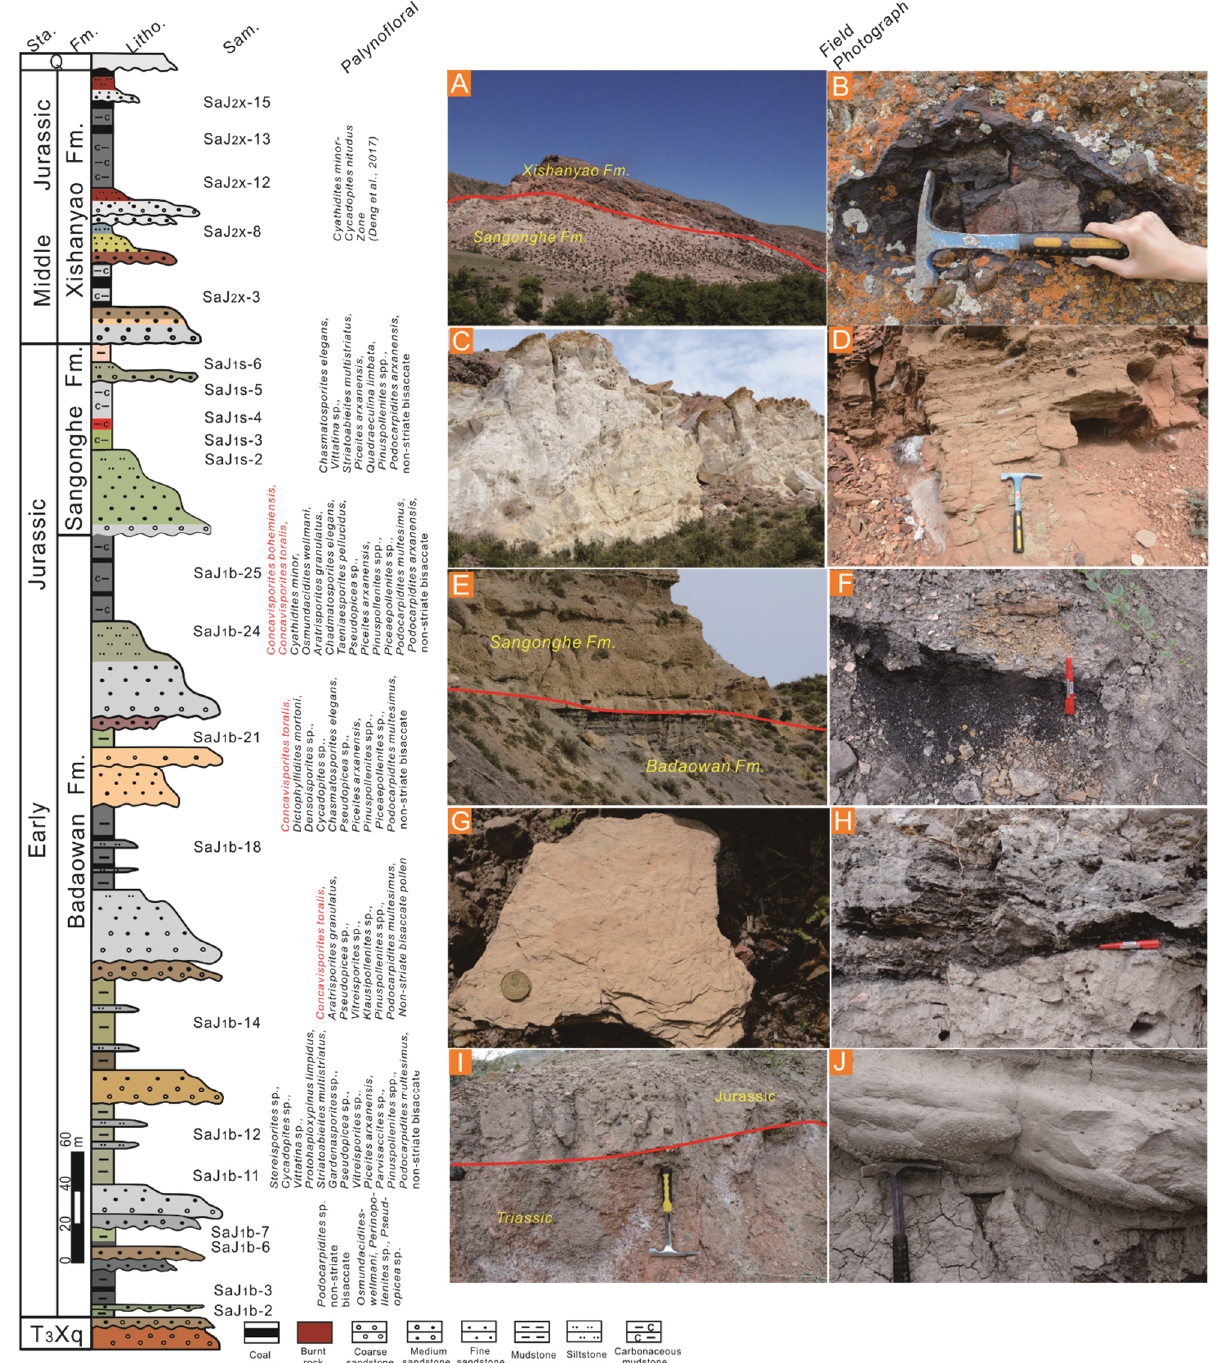
Figure 2. Stratigraphy and outcrop photographs of the Su’asugou section in Yili Basin, Northwest China: Palynological data in the Xishanyao Formation (Fm.) from (Deng et al., 2017) [44]. The color in lithology column is the authigenic color of the sediments. ( A ) Field overview photo of the boundary between the Sangonghe Fm. and the overlying Xishanyao Fm.; ( B ) Burnt rock in the Xishanyao Fm.; ( C ) Field overview photograph of the Sangonghe Fm. overlying the Badaowan Fm.; ( D ) Red siltstone in the Sangonghe Fm.; ( E ) Detail of lithological changes across boundary between the Sangonghe Fm. and overlying Xishanyao Fm.; ( F ) A thin-layered coal in the Badaowan Fm.; ( G ) Plant fossils of linear or ribbon-like leaves in the Badaowan Fm.; ( H ) Carbonaceous siltstone in the Badaowan Fm.; ( I ) Detail of lithological changes across the boundary between Jurassic and Triassic. ( J ) The grey coarse-grained sandstone is the base of the Badaowan Formation. Abbreviations: Sta.= Stage; Fm. = Formation; Litho. = Lithology; Sam. = Sample; SaJ1b, SaJ1s and SaJ2x = Sampled horizons in the Badaowan, the Sangonghe, and the Xishanyao formations, respectively.